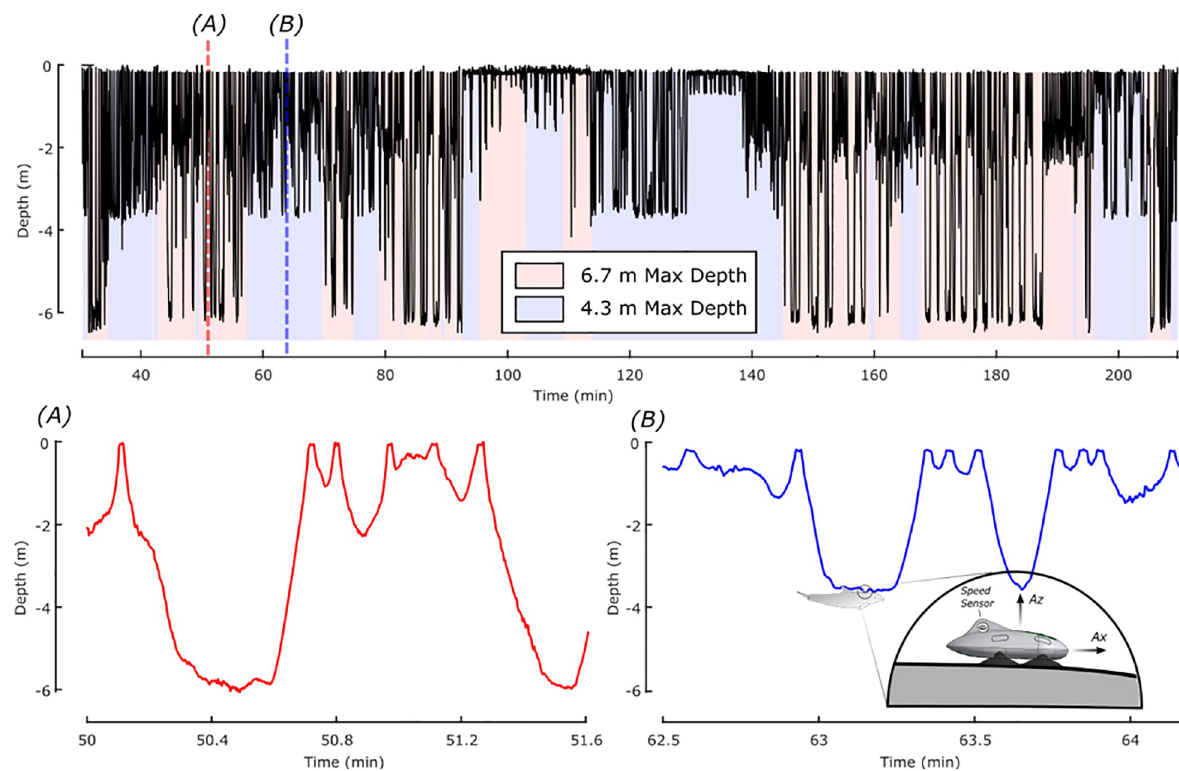
Fig 1. Pressure data. A representative section of pressure data recorded by the MTag in an environment with two areas of different maximum depths (Top). The plot is shaded red when the animal is in the 6.7 m deep area and blue when the animal is in the 4.3 m deep area. Details showing differences in the diving profiles in the two sections of the environment are shown in the bottom left (A, 6.7 m deep area) and right (B, 4.3 m deep area) figures, along with an image of the bio-logging tag used to collect the data